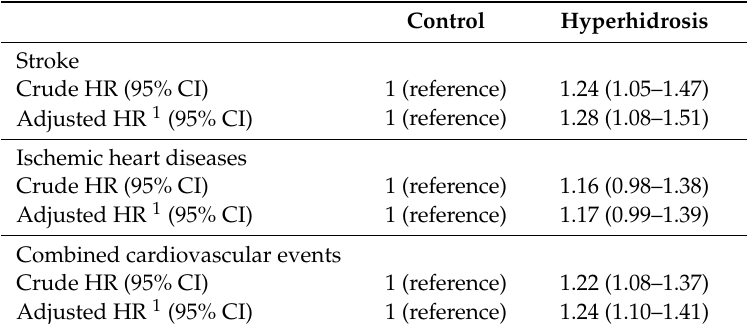
Table 2. Hazard ratio for cardiovascular events according to the presence or absence of hyperhidrosis determined through Cox regression analysis.